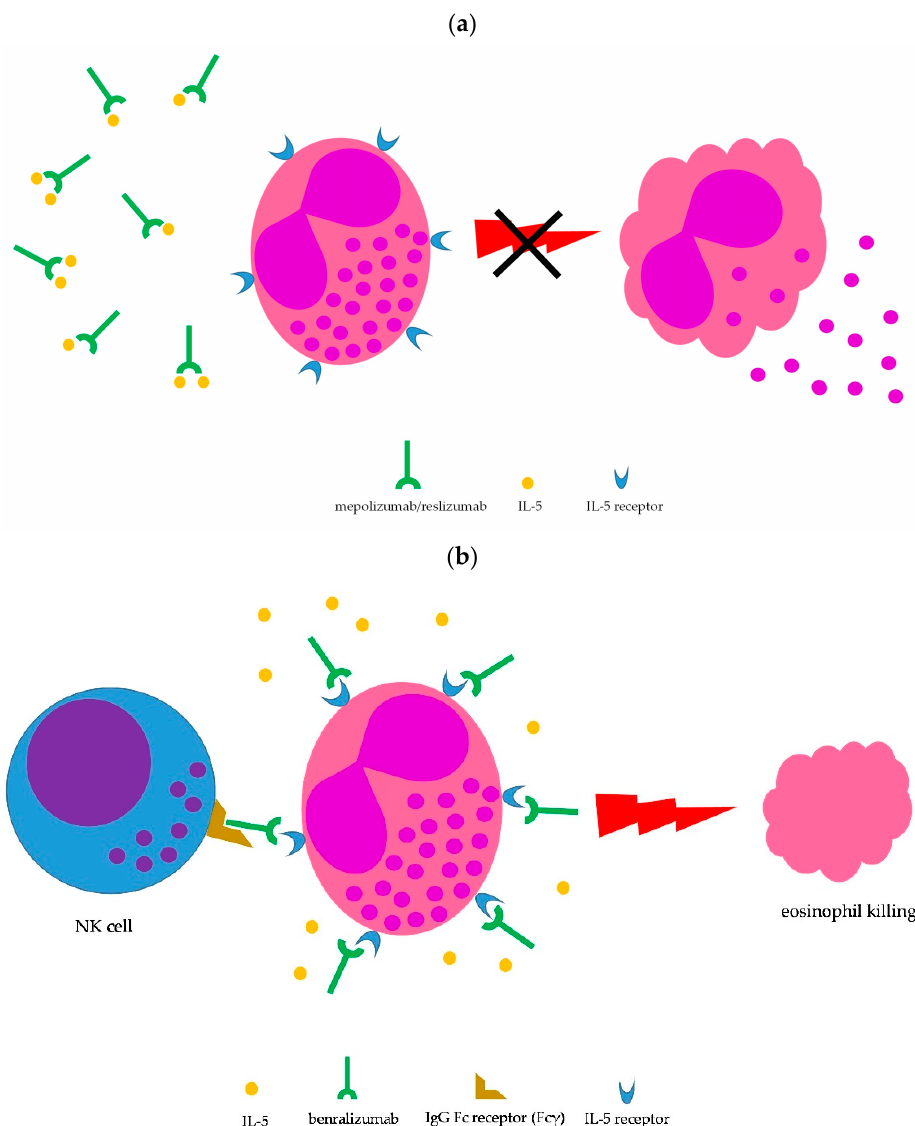
Figure 3. Mechanism of action of IL-5-targeted monoclonal antibodies. ( a ) Blocking IL-5 by mepolizumab and reslizumab prevents eosinophil maturation, proliferation, recruitment, survival, priming, and activation (the latter shown here); ( b ) benralizumab binds to the IL-5 receptor on eosinophils, thus inhibiting cytokine-mediated cell stimulation; in addition, the Fc fragment of benralizumab is able to mediate eosinophil killing by NK cells through antibody-dependent cell cytotoxi- city.